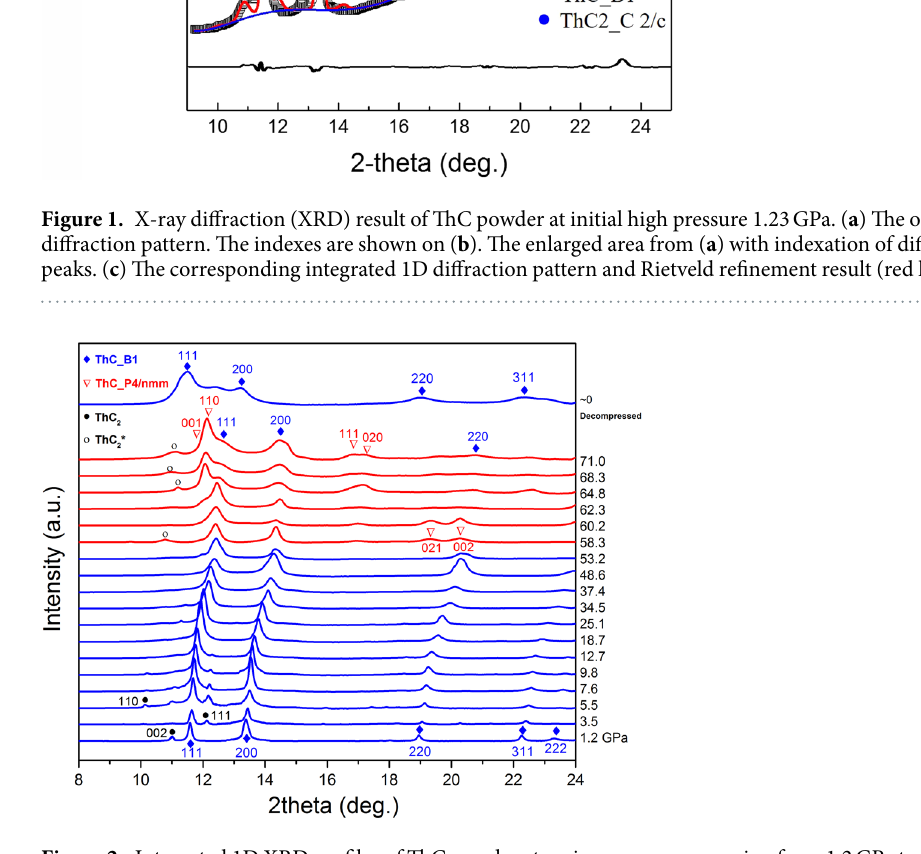
from the possible shear stresses in the sample due to the imperfect hydrostaticity of silicon oil. Starting from 58.3 GPa, new diffraction peaks show up at around 17 and 19 degrees, indicating the onset of a new phase. These peaks are identified as (111), (020) and (021) of the P4/nmm ThC. Another evidence of the new phase can be seen